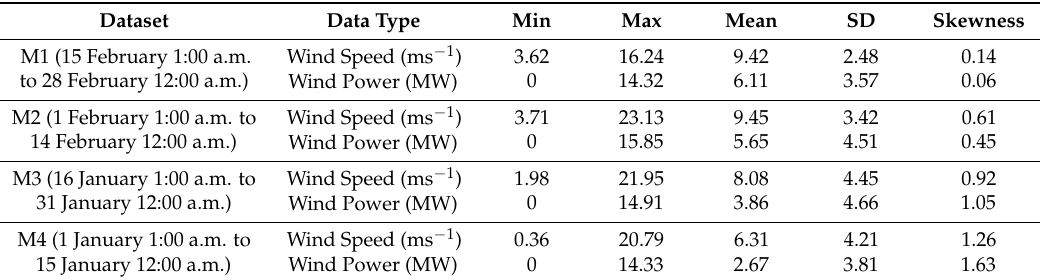
Table 1. Statistics of hourly wind speed and wind power time